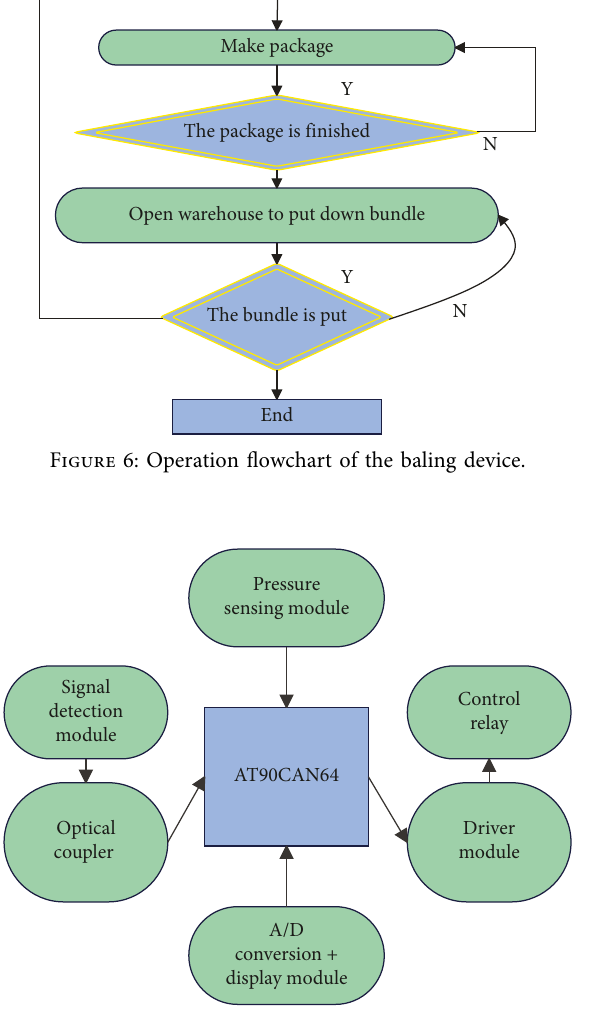
Figure 7: Schematic diagram of the control system of the coating